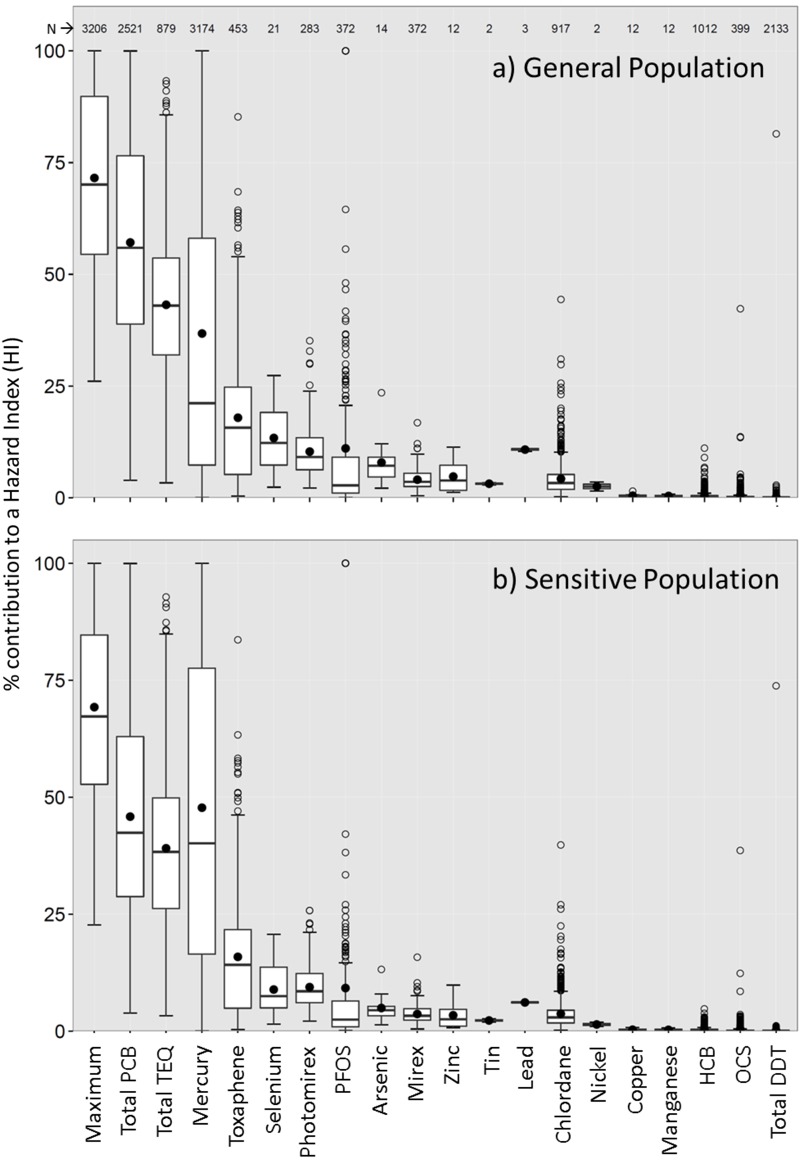
Percent contribution of contaminant-specific hazard quotient (HQ) to the hazard index (HI) calculated using the multi-chem advisory approach for (A) the general population and (B) sensitive population. The maximum is the highest contribution of an HQ to an HI regardless of contaminant. The solid circle indicates the mean, the line within the box indicates the median, the box indicates the 25th and 75th percentiles, the whiskers indicate the highest and lowest values not classified as statistical outlier values < 1.5 times away from the interquartile range. Nondetect values were excluded. Similar results for a data set that included nondetects are presented in Figure S9. DDT, dichlorodiphenyltrichloroethane; HCB, hexachlorobenzene; OCS, octachlorstyrene; PCB, polychlorinated biphenyl; PFOS, perfluorooctane sulfonate; TEQ, toxic equivalent.